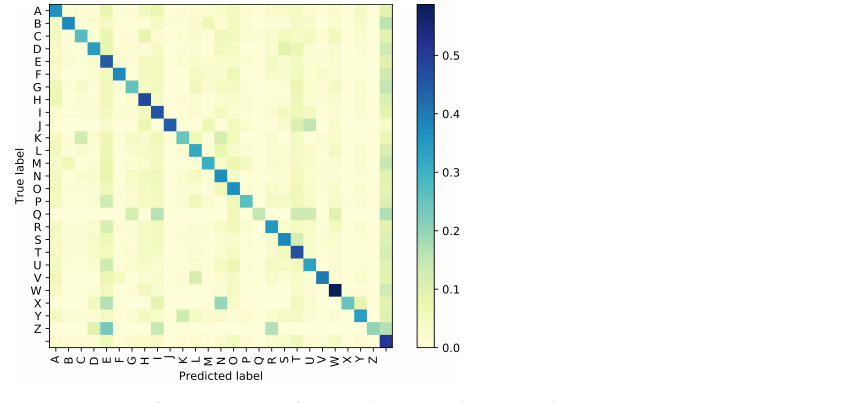
Figure 8. Confusion Matrix for Feed-Forward Network. Table 4. Performance of viseme-to-word converters for Situation 1 on the LRS2